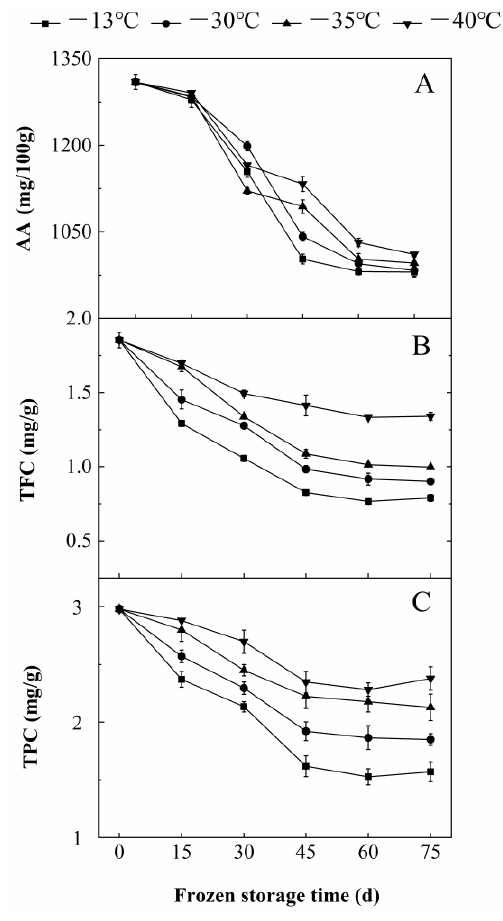
Figure 3. Effect of freezing time and temperature on the content of ( A ) AA, ( B ) TFC and ( C ) TPC of sea buckthorn berries. Bars indicated standard error (±SD). The - ■ -, - ● -, - ▲ -, - ▼ - show the freezing temperature of −1 3, −3 0, −3 5 and −4 0 °C, respectively. The data are mean values of three replicates.